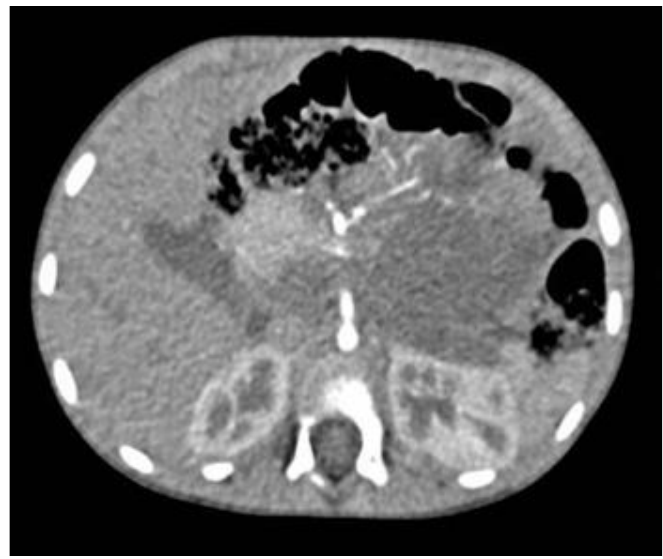
Figure 1. Neuroblastoma computed tomography axial section: encasement of the coeliac trunk and aorta. An encasement is radiologically defined when the vascular surface is > 50% surrounded by the tumor.